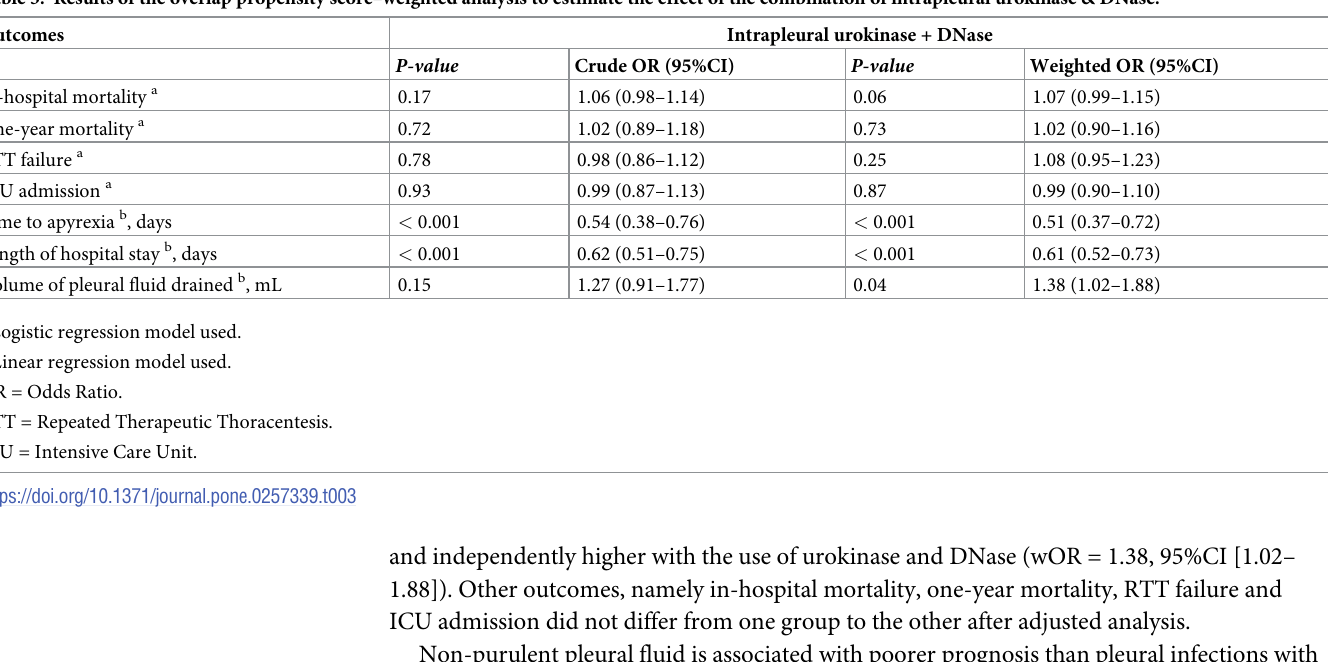
Table 3. Results of the overlap propensity score–weighted analysis to estimate the effect of the combination of intrapleural urokinase &